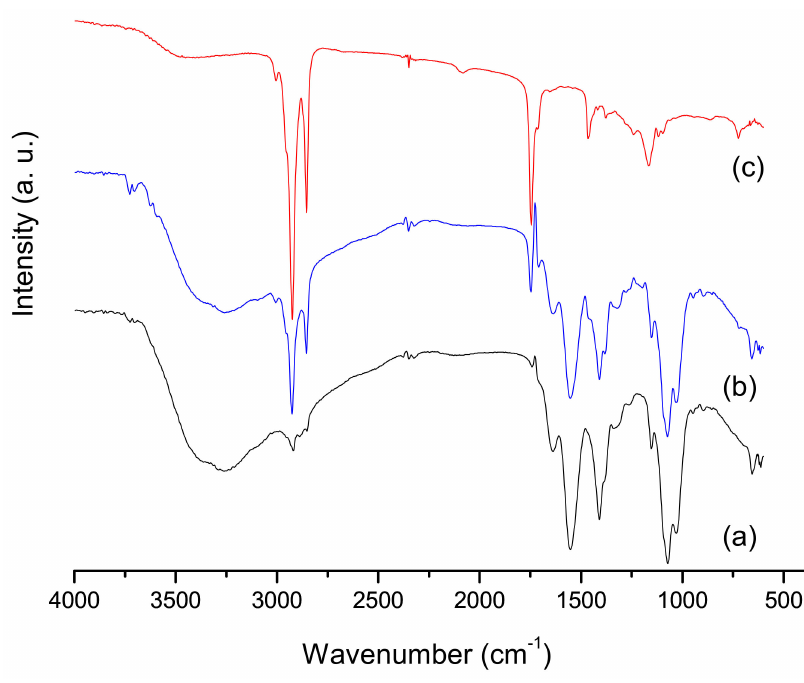
Figure 2. I nfrared spectroscopy (FTIR) spectrum of chitosan gel (a), chitosan gel with buriti oil (b), and buriti oil